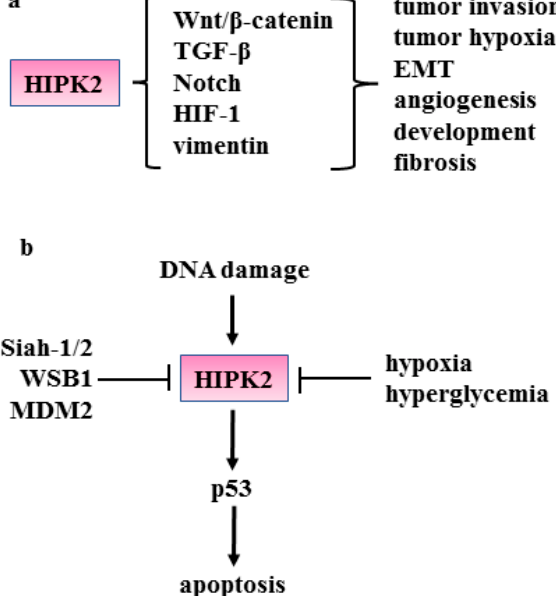
Figure 4. ( a ) Schematic representation of the molecular pathways regulated by HIPK2 and the underlying outcome. ( b ) HIPK2 is activated by DNA damage and consequently activates the p53 apoptotic function. HIPK2 is inhibited by hypoxia and hyperglycemia and by the Siah-1/2, WSB1 and MDM2 ubiquitin ligases. Black arrows indicate activation.